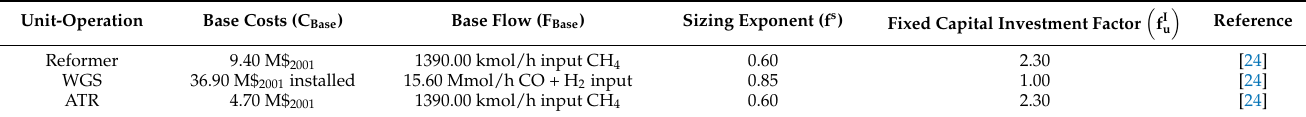
Table 8. Literature values for base costs for reforming equipment.